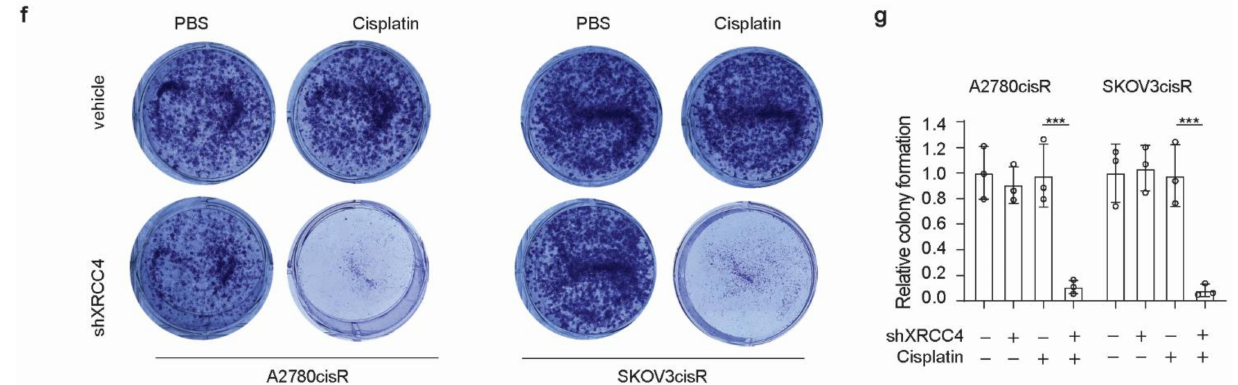
Figure 2. Knockdown of XRCC4 sensitized cisplatin treatment in the cisplatin-resistant ovarian cancer cells. ( a ) Confirmation of the knockdown of XRCC4 by 2 shRNAs in A2780cisR and SKOV3cisR treated with or without cisplatin by Western blot. ( b ) Cell viability of XRCC4 knockdown or vehicle control A2780cisR and SKOV3cisR cells treated with or without sublethal doses of cisplatin (5 µ g/mL A2780cisR and 2 µ g/mL SKOV3cisR) for 48 h. Cell viability was determined by CellTiter-Glo luminescent cell viability assay. ( c ) Cisplatin IC50 of A2780cisR and SKOV3cisR with or without XRCC4 knockdown. ( d – g ) Representative cell apoptosis ( d ), related quantification ( e ), representative colony formation potential ( f ), and related quantification ( g ) of A2780cisR and SKOV3cisR. Cells were transduced with XRCC4 shRNA clone and sublethal doses of cisplatin (5 µ g/mL A2780cisR and 2 µ g/mL SKOV3cisR) for 48 h. Data are mean ± SD from 3 technical replicates of each sample and are representative of 2 ( a ), 2 ( b ), 2 ( c ), 3 ( d ), and 2 ( f ) independent biological experiments. Statistical analysis was performed by 1-way ANOVA for ( b , d , e ); *** p < 0.001; **** p <